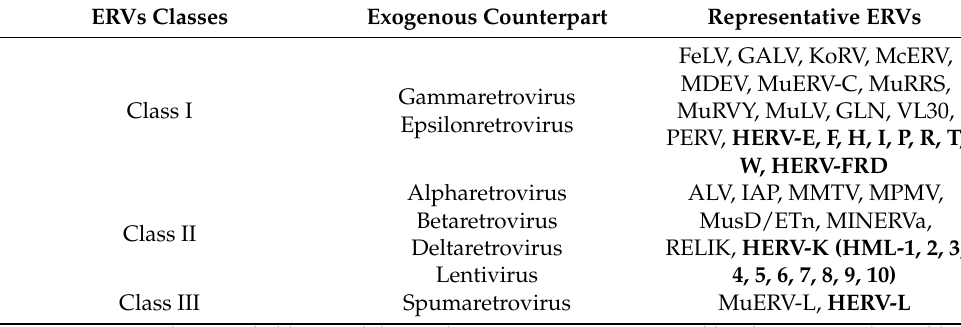
Figure 1. Organization and structure of transposable elements (TEs). ( A ) Pie chart shows the proportion of various selected genomic features within the human genome. ( B ) Genomic structures of LINE, SINE, and ERV. The general structure of a full-length ERV is shown. AR, adenine (A)-rich region. pA, poly (A) tail. PBS, primer binding site. PPT, polypurine tract. Table 1. Classification of ERVs.